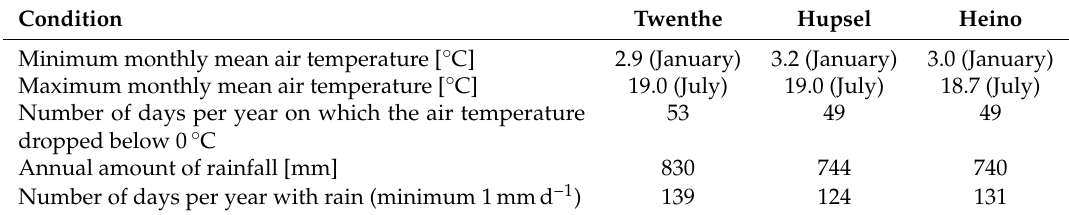
Table 1. Summary statistics of the measurements by the three KNMI weather stations [43] in the Twente region, averaged over five hydrological years (1 April 2014–31 March